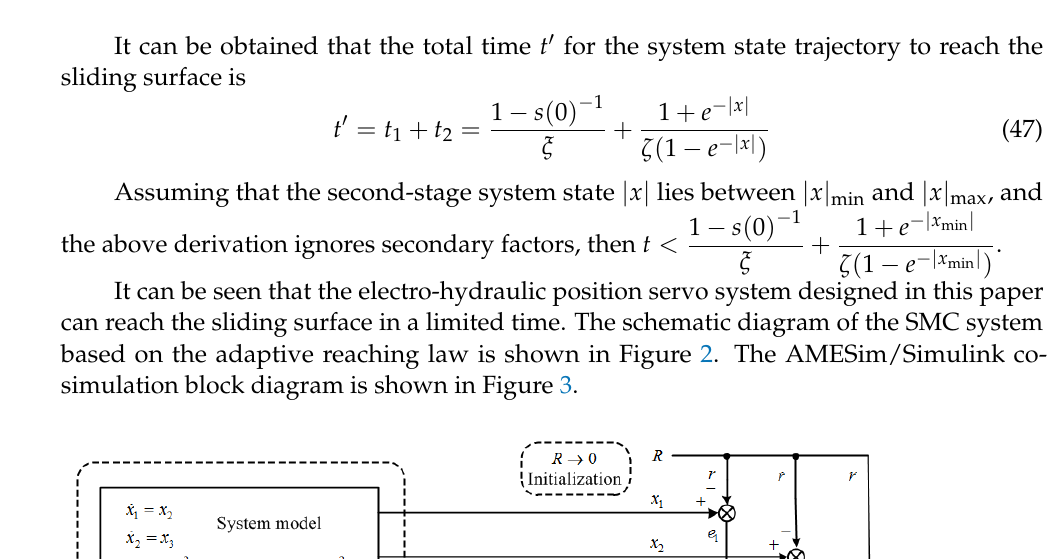
Table 1. Parameters of electro ‐ hydraulic position servo system.